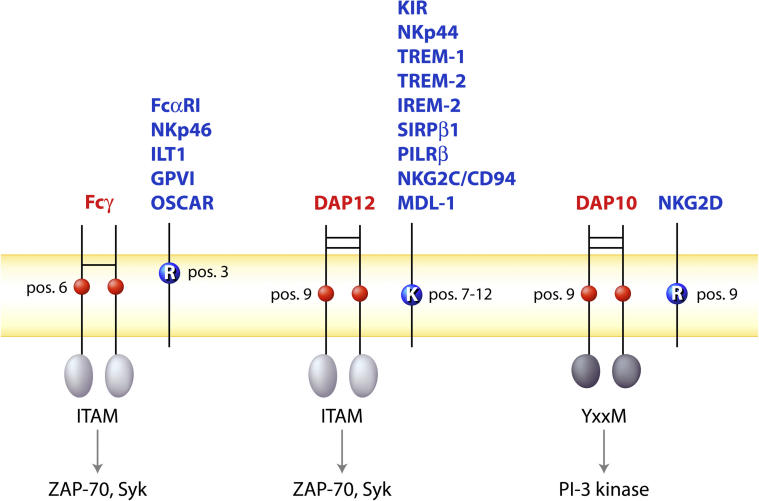
Mechanisms for Selective Assembly of a Diverse Group of Receptors with their Signaling ModulesThe Fcγ and DAP12 signaling modules are expressed by a variety of different cell types of hematopoietic origin and serve as signaling subunits for many different receptors. Fcγ and DAP12 exhibit a preference for a particular basic side chain, Fcγ for arginine (R) and DAP12 for lysine (K). The location of the ionizable TM residues also contributes to specificity of assembly, an aspect that is important because Fcγ and DAP12 are co-expressed by a number of different cell types. The DAP10 signaling dimer assembles only with NKG2D and initiates signaling through interaction with the p85 subunit of PI-3 kinase, while the other two adaptors signal through ZAP-70 or Syk tyrosine kinases.